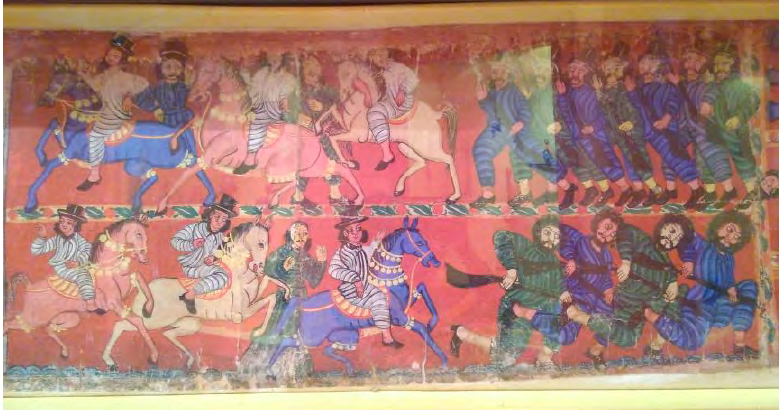
Figure 4, close up of the Saheb Pata, National museum, New